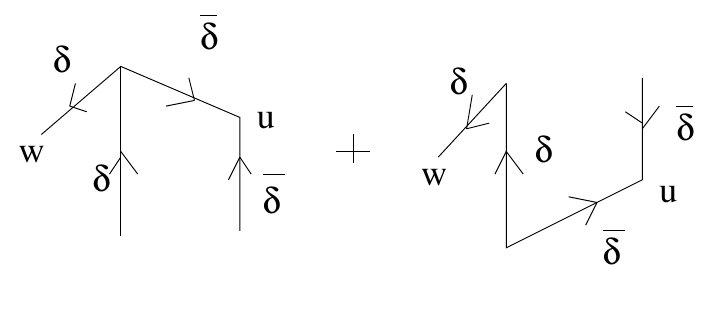
Figure 5 . Skeleton graphs for (cid:8) 2 ;B